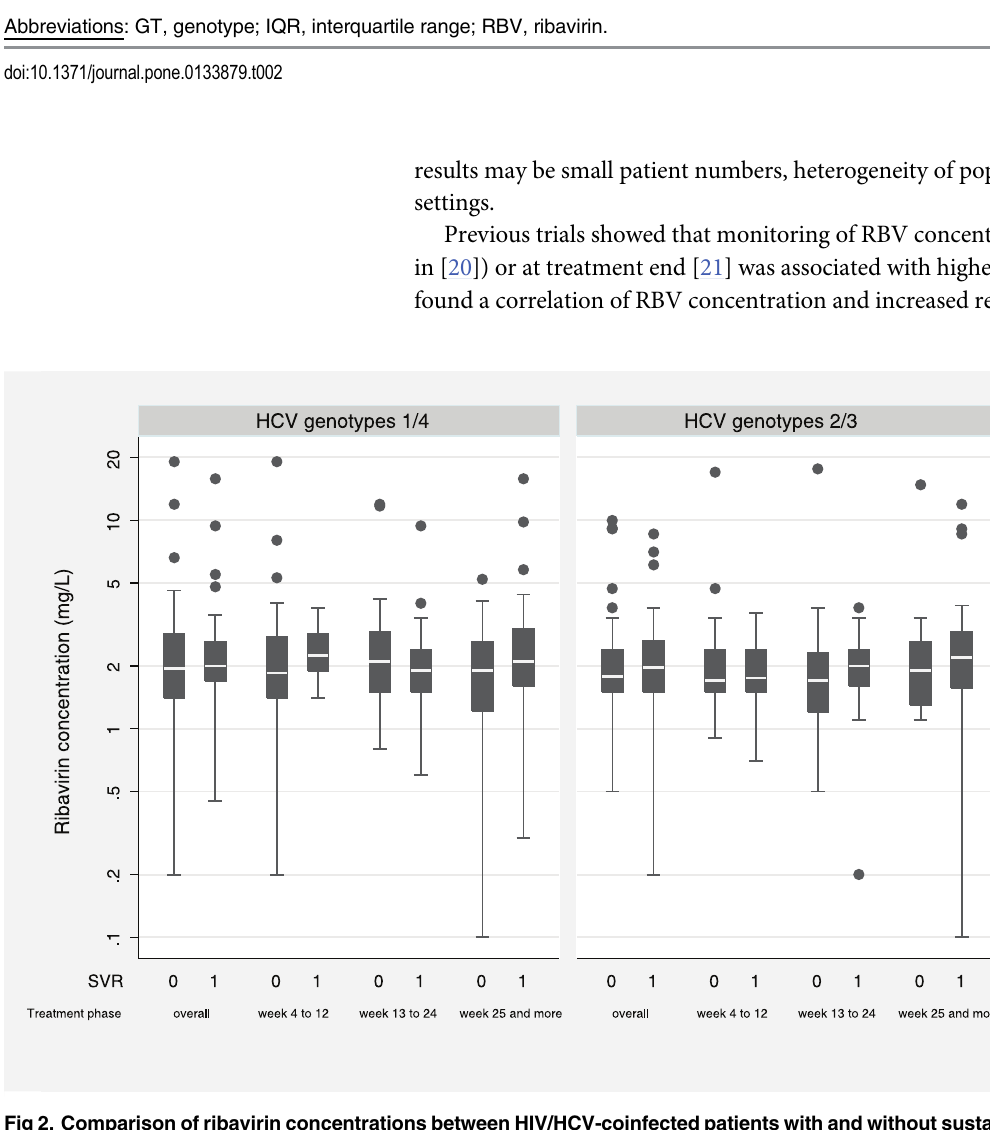
Fig 2. Comparison of ribavirin concentrations between HIV/HCV-coinfected patients with and without sustained virological response (SVR), stratified by HCV genotype and treatment phase. Abbreviations: SVR, sustained virological response; 0, no SVR; 1,